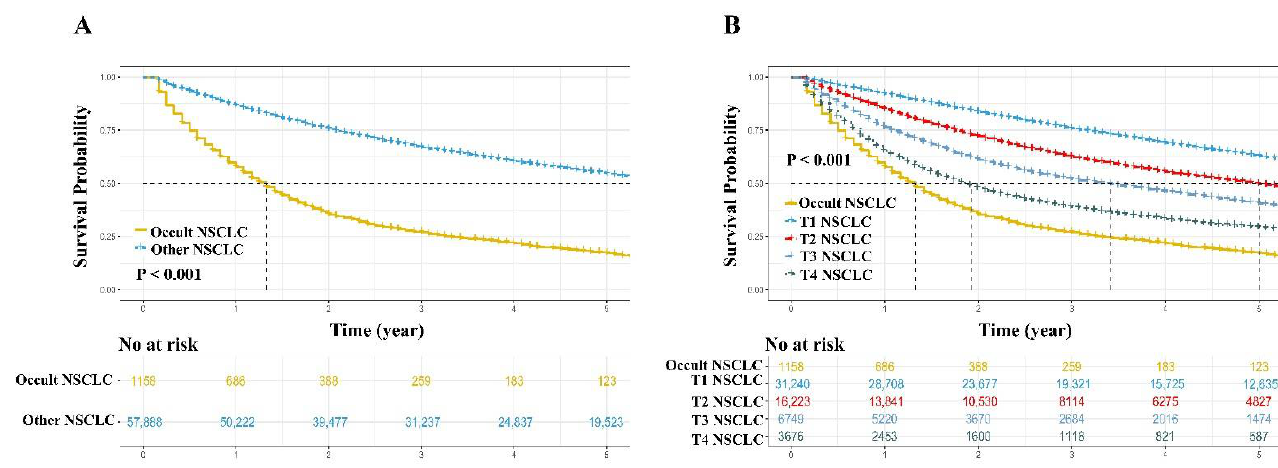
Figure 4. The overall survival comparisons. Occult NSCLC vs. other NSCLC ( A ) and occult NSCLC vs. T1 stage NSCLC vs. T2 stage NSCLC vs. T3 stage NSCLC vs. T4 stage NSCLC ( B ). NSCLC, non-small cell lung cancer.